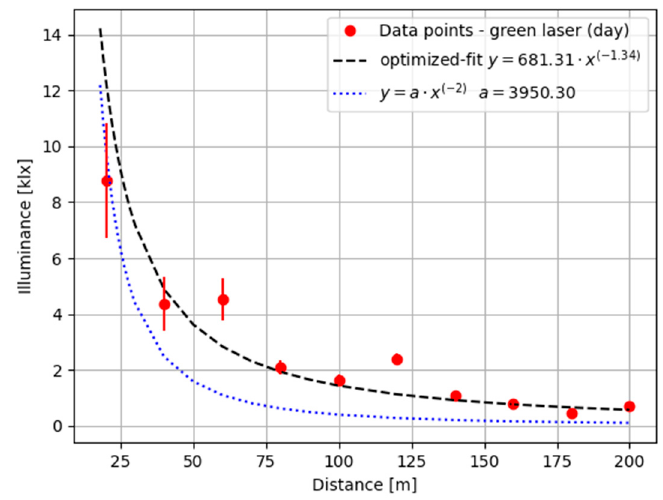
Figure 5. Dependence of the illuminance on the distance of the green laser during the day.